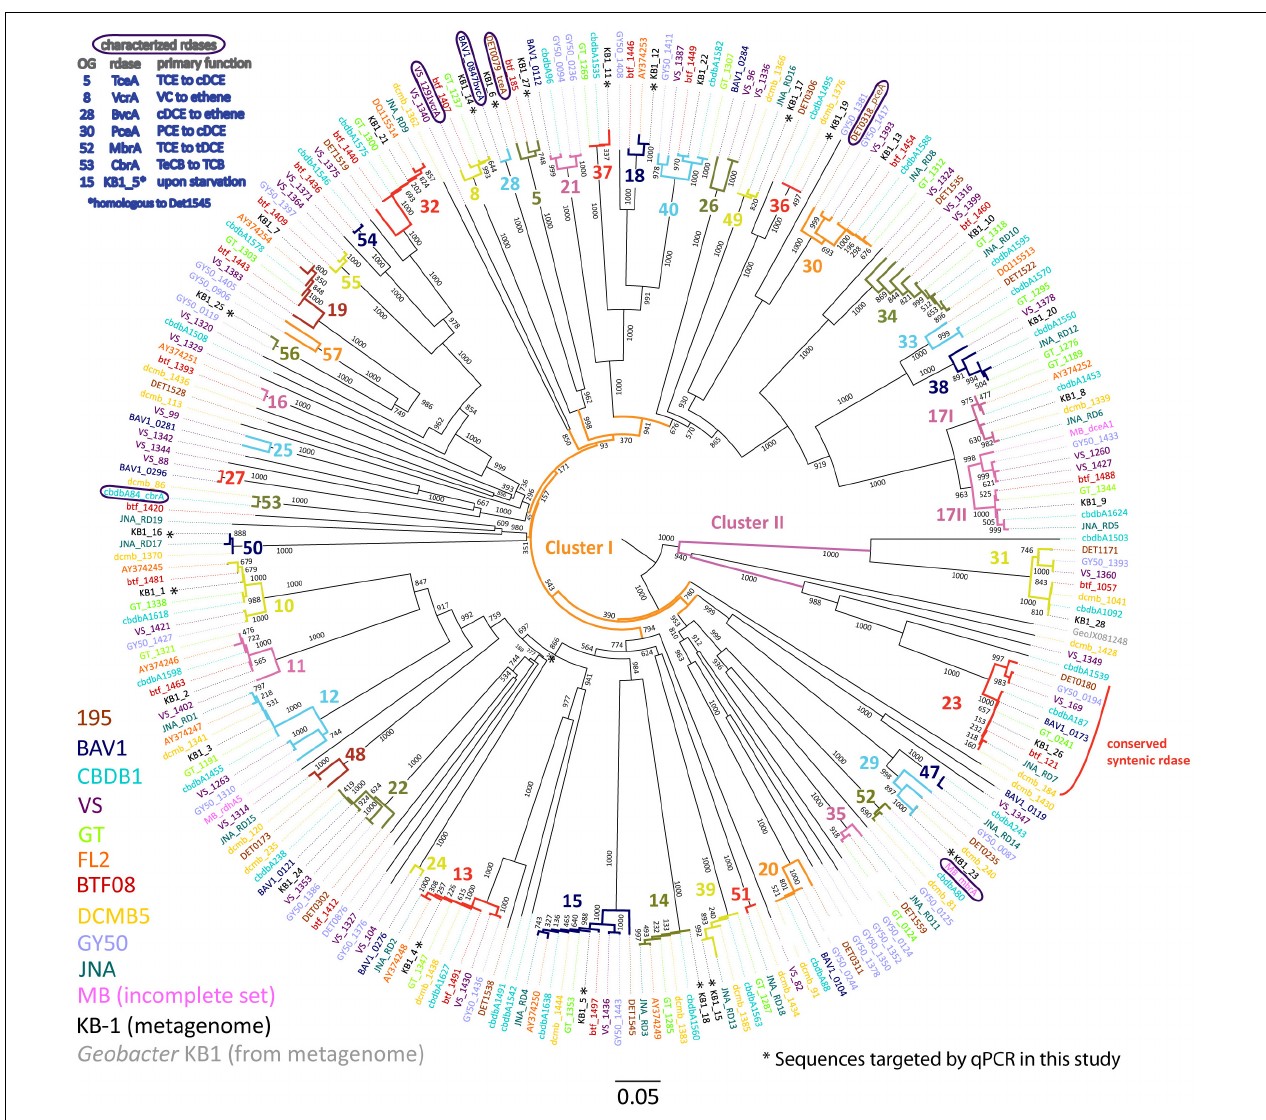
FIGURE 1 | Phylogenetic tree of Dehalococcoides mccartyi reductive dehalogenases based on amino acid sequences. Tree includes sequences predicted from 248 rdhA genes found in eleven isolated D. mccartyi strains as well as those found in the mixed dechlorinating culture KB-1, including the rdhA gene sequence found in Geobacter KB-1 as an outgroup. The scale is the number of substitutions per amino acid. Bootstraps are shown at tree nodes. Sequences names are colored corresponding to their source as shown in the legend at bottom left. The numbers and different branch colors highlight ortholog groups (OGs) where sequences have > 90% PID. Sequences corresponding to characterized RDases are circled and their substrates shown in the top right legend (chlorinated substrate abbreviations as in text, plus TeCB, tetrachlorobenzene; TCB, trichlorobenzene).